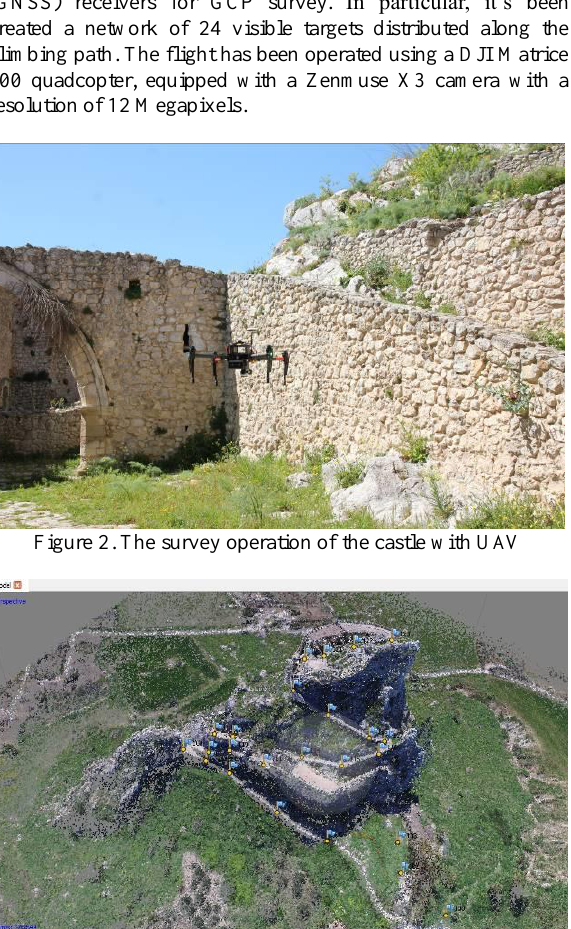
Figure 6. An example of a sparse cloud reconstruction of an indoor environment of the